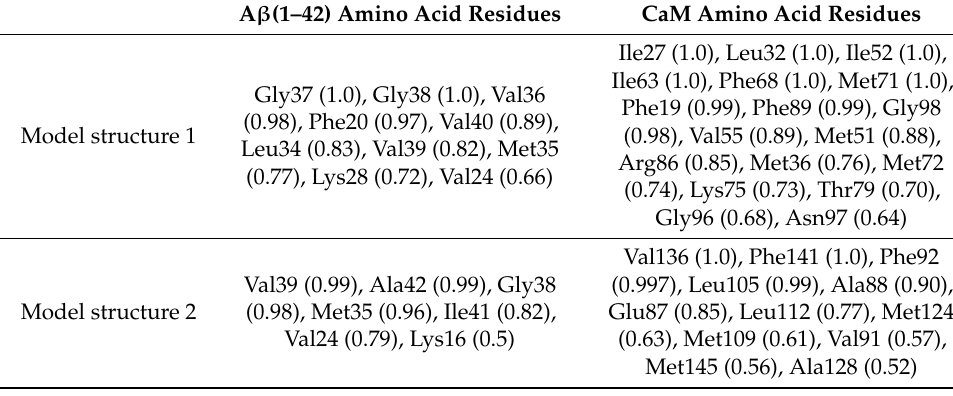
Table 1. A list of the strongly interacting amino acid residues of A β (1–42) and CaM in structures 1 and 2 yielded by docking simulations for the 1:1 A β (1–42):CaM complex. The amino acid residues of both A β (1–42) and CaM are listed from high to low values of the parameter BSA/ASA (values in parenthesis), obtained from the interface analysis with PDBePISA software. Only amino acids with BSA/ASA values ≥ 0.5 are